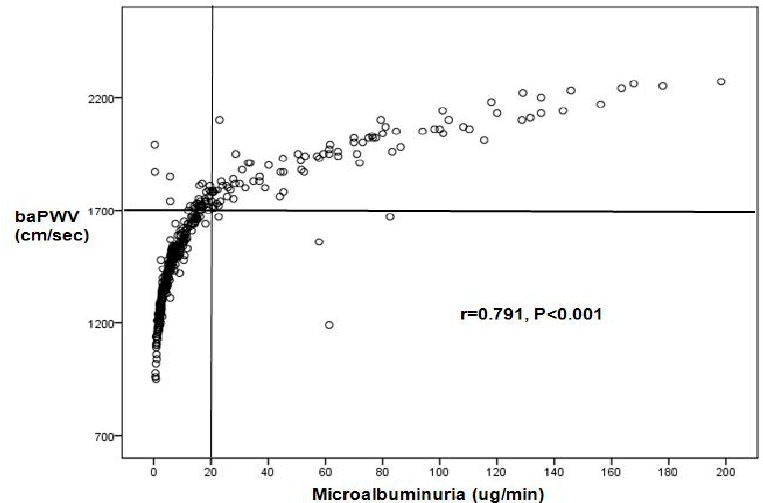
Figure 1. The relationship between microalbuminuria (MAU) and brachial-ankle pulse wave velocity (baPWV).